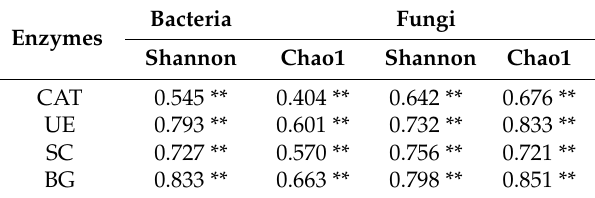
Table 5. Spearman’s correlation between soil enzyme activities and microbial diversity indices. Bacteria Fungi Enzymes Shannon